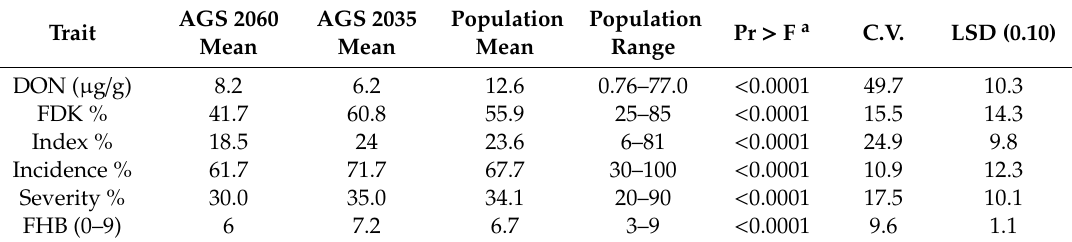
Table 4. Descriptive statistics for FHB resistance ratings of AGS 2060 x AGS 2035 DH population at Winnsboro 2019.